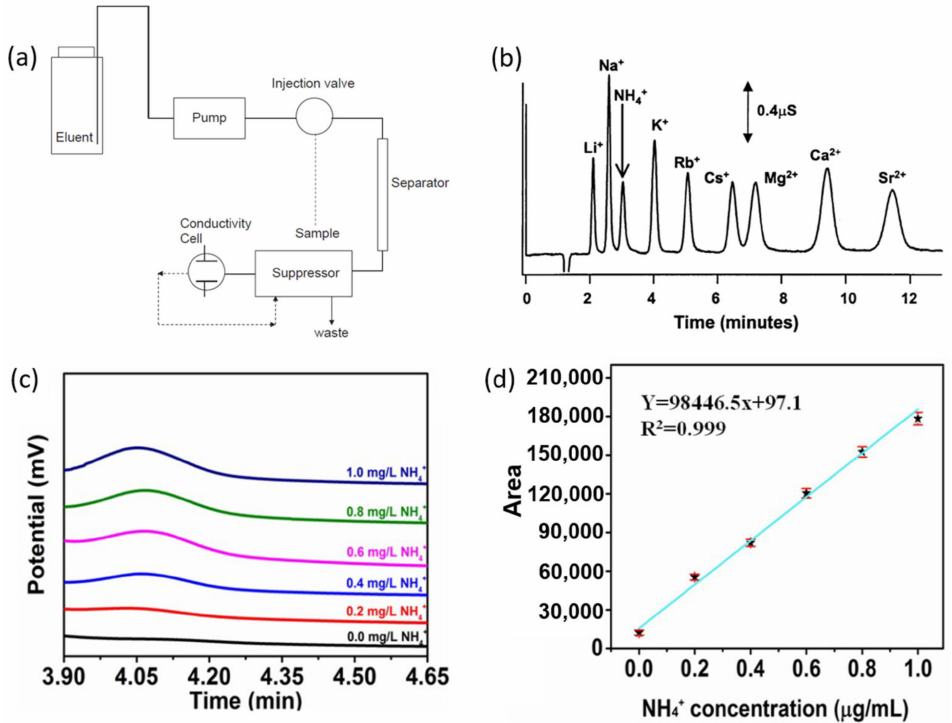
Figure 4. ( a ) Schematic diagram of standard IC instrument. Adapted from Ref. [50] Copyright 2017, Elsevier. ( b ) High-speed separation of nine common cations at 27 ◦ C. Experiment was performed using Dionex CS-12A cation exchange column (carboxylate-functionalized cation-exchange